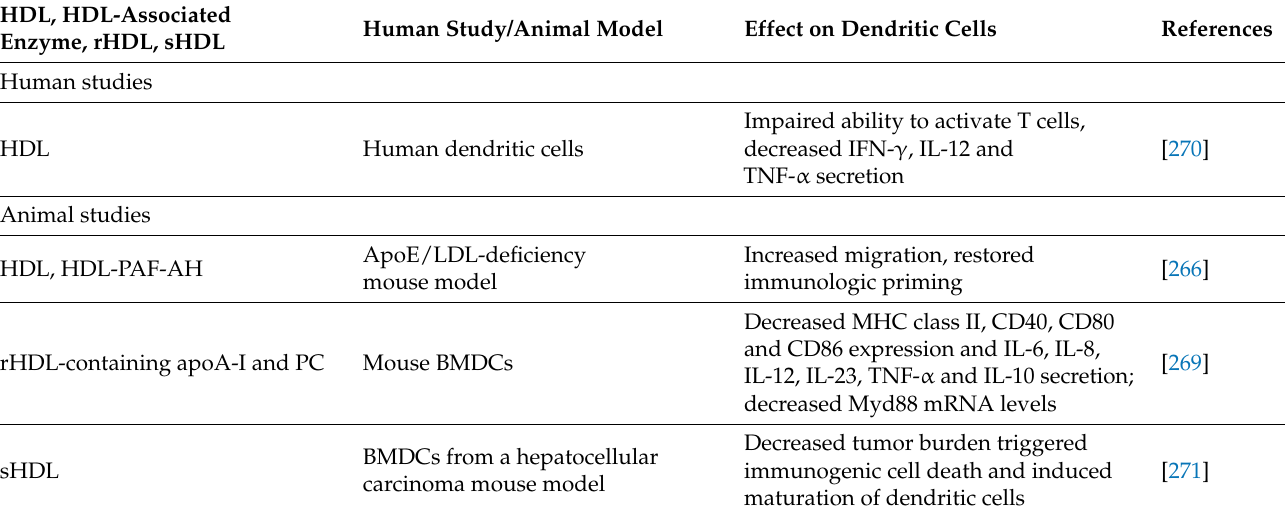
A summary of the effects of HDL, reconstituted and synthetic HDL, as well as HDL-associated enzymes on dendritic cell activation and functional properties is given, as described from human studies utilizing monocyte-derived dendritic cells or studies utilizing